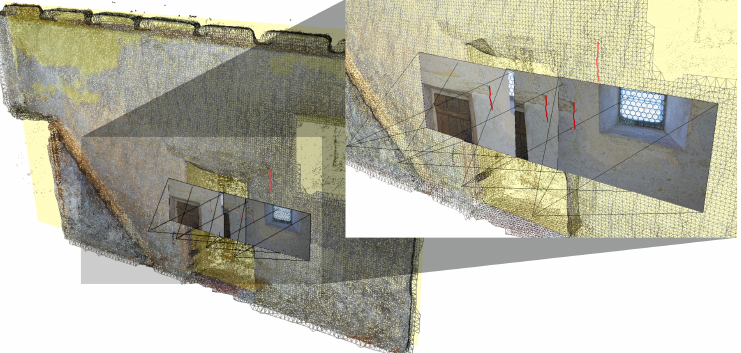
Figure 11. Back-projection of a crack annotation on Wall 01 to images containing the